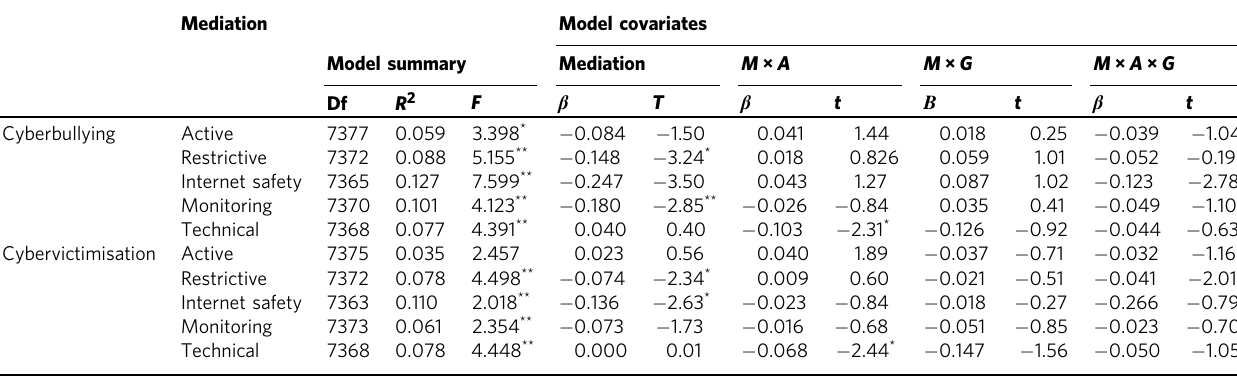
Table 6 Model summary and coef fi cients of moderation analyses.